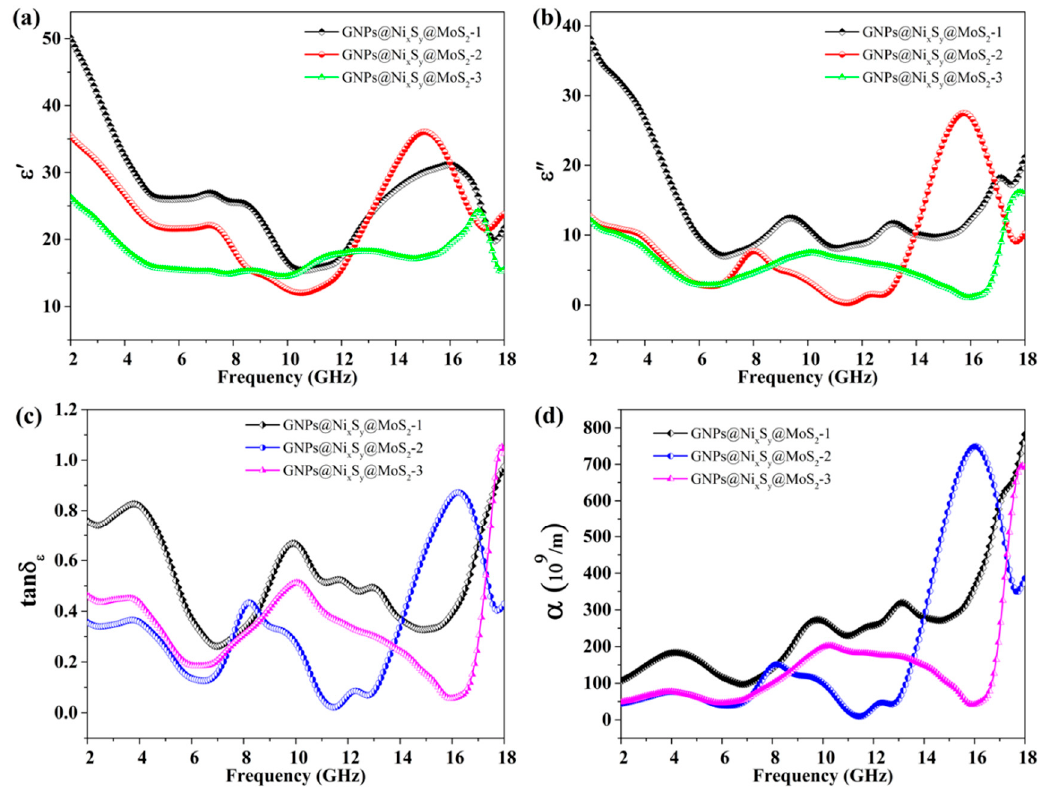
Figure 8. Electromagnetic parameters ( a , b ), tangent of dielectric loss ( c ) and α ( d ) of GNPs@Ni x S y @MoS 2